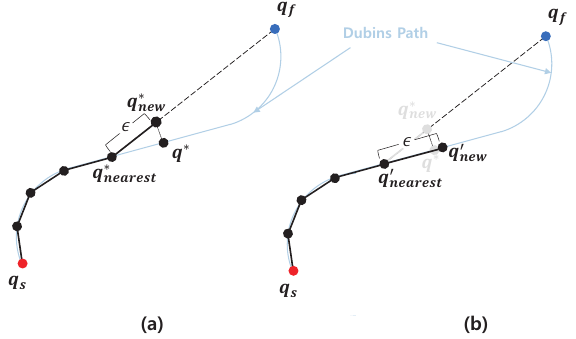
Figure 4. Optimization improvement method: ( a ) Closest point search algorithm. ( b ) Extend